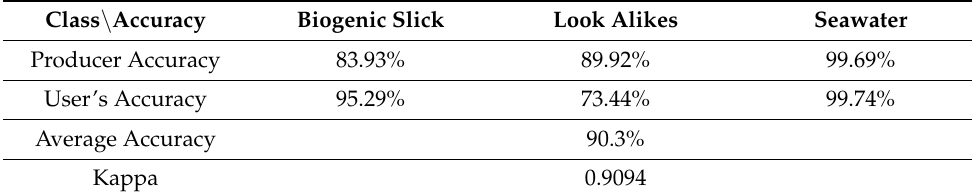
Figure 12. Results of the Random Forest classifier and importance ordering of polarimetric features in study area 2 : ( a ) oil spill detection results; ( b ) variable importance ordering. Table 5. Classification accuracies of the Random Forest classifier in study area